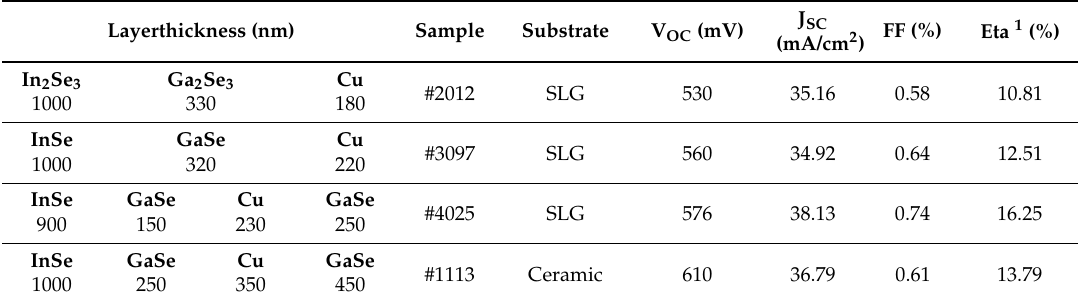
Table 1. Comparison between the photovoltaic parameters of 1 cm 2 CIGS-based solar cells, fabricated with the different methods on glass and ceramic substrates at the ThiFiLab, whose characteristics are reported in Figure A1. Soda-lime glass: